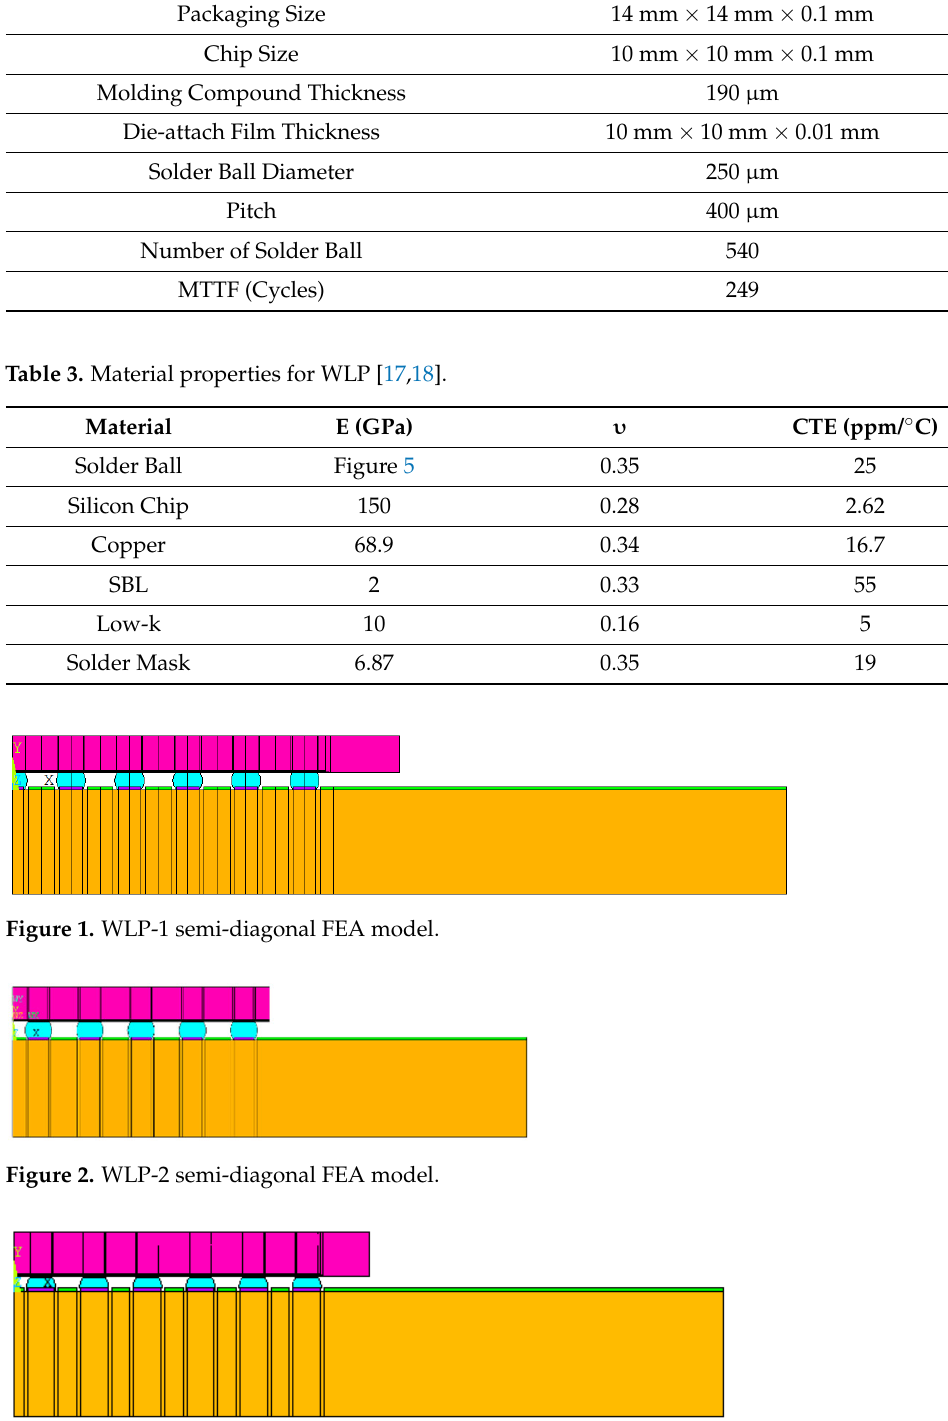
Figure 4. FO-WLP and the schematic of critical mesh size. The FEA model for WLP 1-5 includes the following materials: silicon chip; low-k layer; stress buffer layer (SBL); redistribution layer (RDL); solder ball; under bump met- allurgy (UBM); copper pad; printed circuit board (PCB); and solder mask. In addition, to further simplify the 2D model, the actual model simplifies the connection between UBM and the solder ball. The element mesh size in the upper-right corner of the solder ball would affect the final simulation result. Based on our previous research experience, the mesh size of this key position is fixed; it is located on the upper-right corner of the outmost